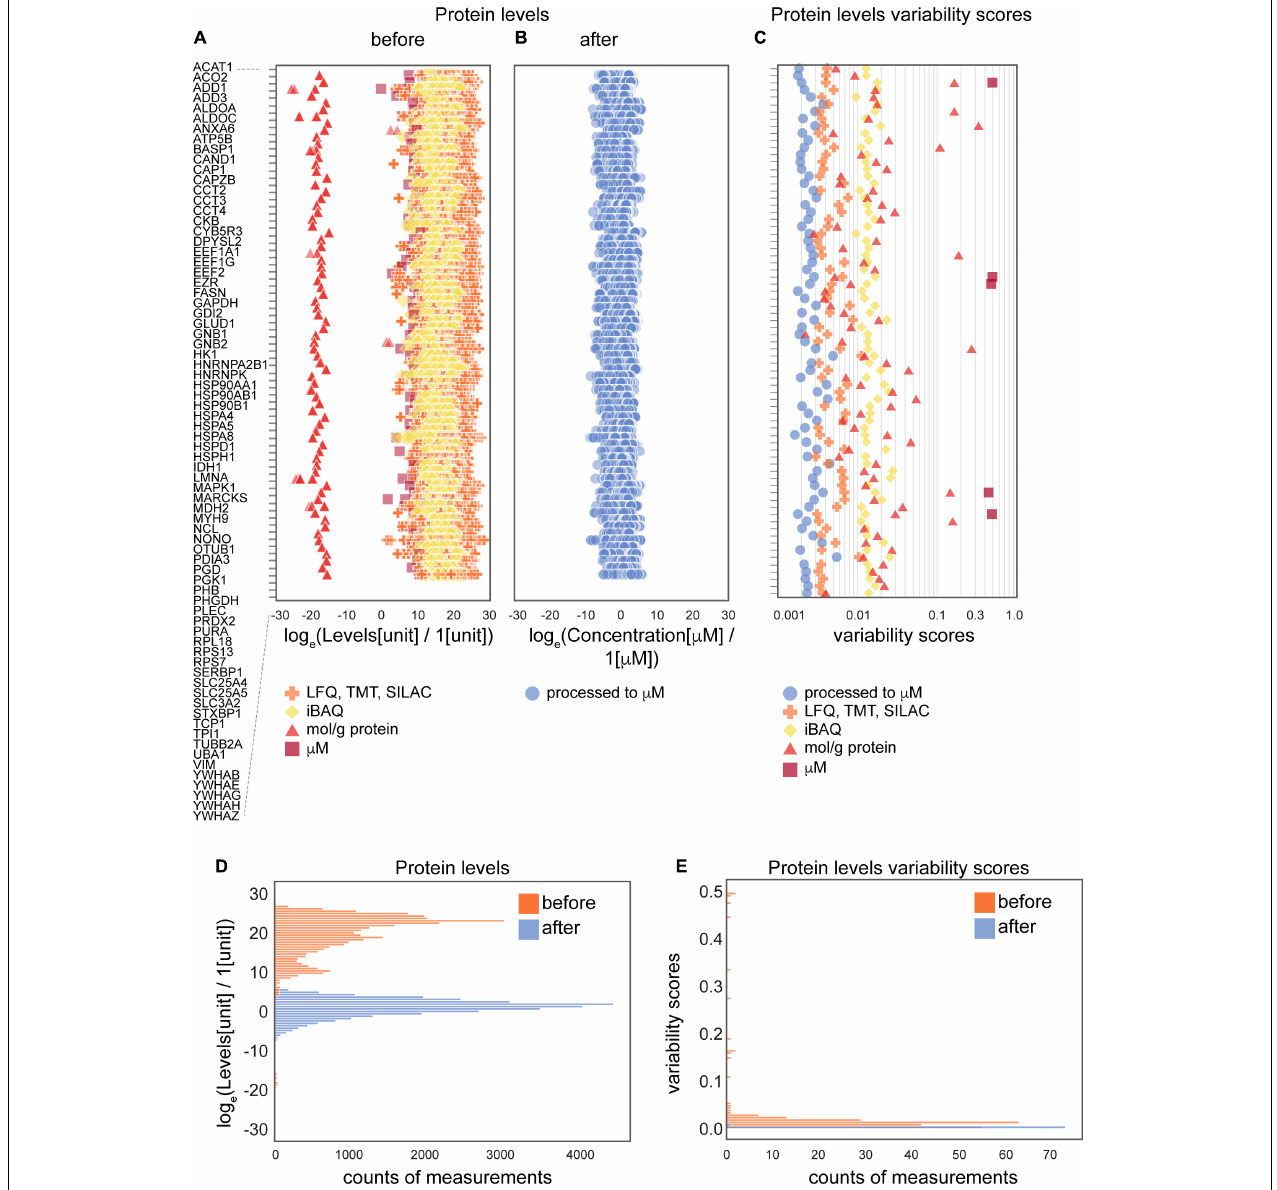
FIGURE 3 | The effects of the data processing pipeline on protein levels. (A,B) Protein levels before (A) and after (B) normalization; and levels variability scores (C) of 74 proteins that are present in the largest number of collected data sets (24 of 25 data sets). (D,E) Histograms of protein levels (D) and variability scores (E) for the same set of 74 proteins as in panels (A–C) . Abbreviations: log e = natural logarithm, LFQ = label-free quantification; TMT = tandem mass tag; SILAC = stable isotope labeling by/with amino acids in cell culture; iBAQ = intensity-based absolute quantification. Sample sizes are available from the Supplementary Presentation